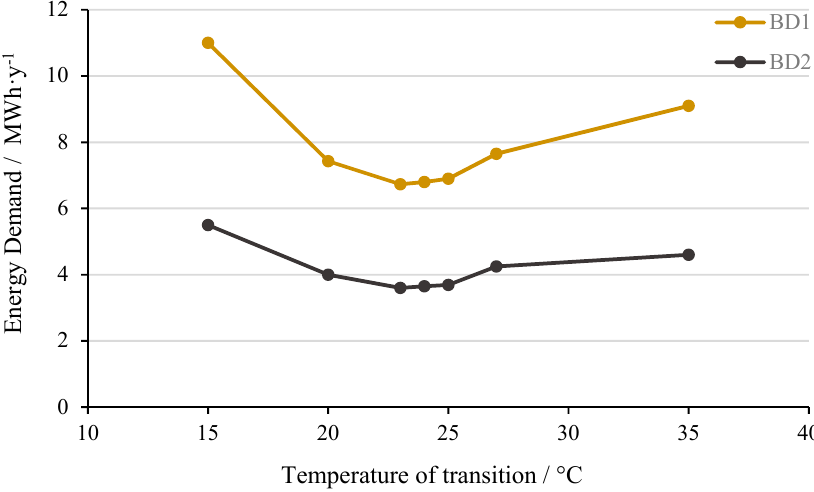
Figure 5. Annual energy demand for building configurations BD1 and BD2 located in Madrid, Spain, considering different transition temperatures for the thermochromic paint.